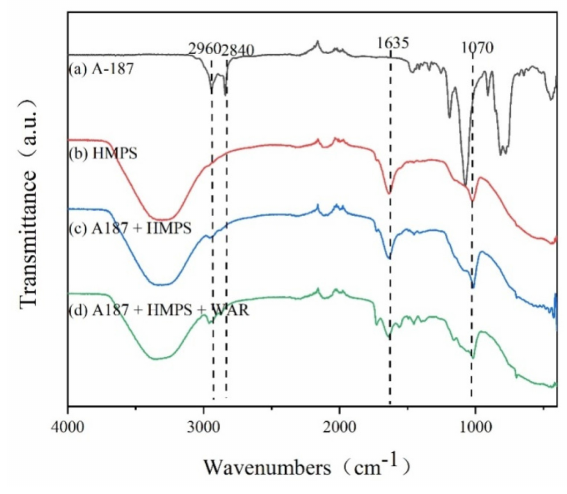
Figure 2. FTIR spectra of ( a ) A − 187, ( b ) High modulus potassium silicate (HMPS). ( c ) A − 187 + HMPS and ( d ) A − 187 + HMPS + Waterborne acrylic resins (WAR).